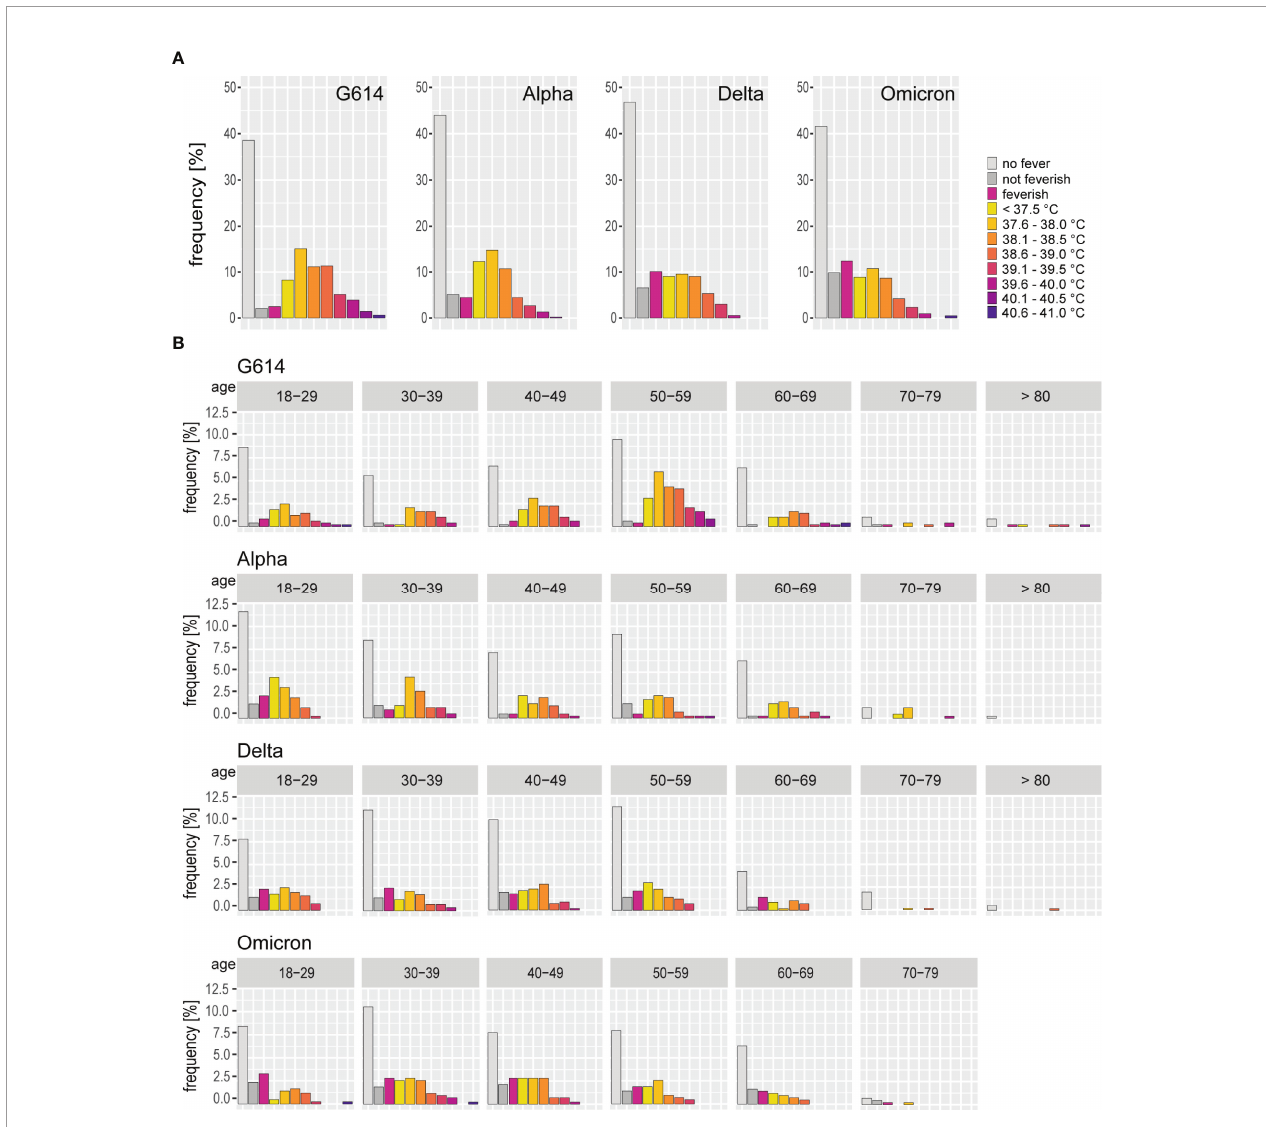
FIGURE 6 | Detailed fever data strati fi ed by SARS-CoV-2 variants and age groups. (A) Frequency of the fever levels reported by participants in the SARS-CoV-2 G614, alpha, delta and omicron dominated phases of the pandemic. (B) Frequency of fever levels reported by the participants in the SARS-CoV-2 G614, alpha, delta and omicron variant dominated phases strati fi ed by age groups. The frequency of participants replying with “ feverish ” who had not measured their body temperature increased in the variant phases, introducing more uncertainty into the fever data. However, the frequency of participants reporting no fever or not feeling feverish increased, suggesting a reliable decrease in fever induced by the SARS-CoV-2